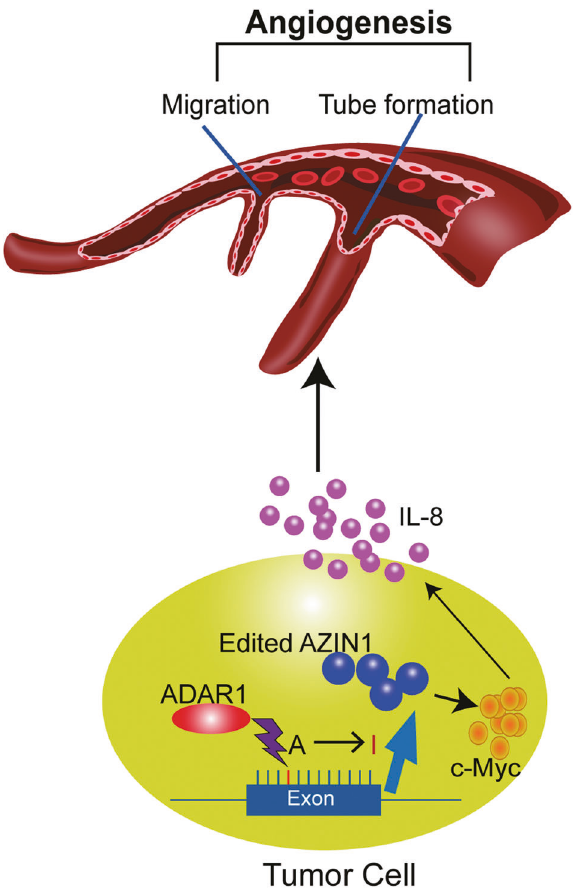
Fig. 8 Schematic summary of the proposed mechanism of edited AZIN1 in promoting tumor angiogenesis. RNA-edited AZIN1 promoted tumor angiogenesis through the upregulation of IL-8, and delaying c-Myc degradation contributed to increasing IL-8